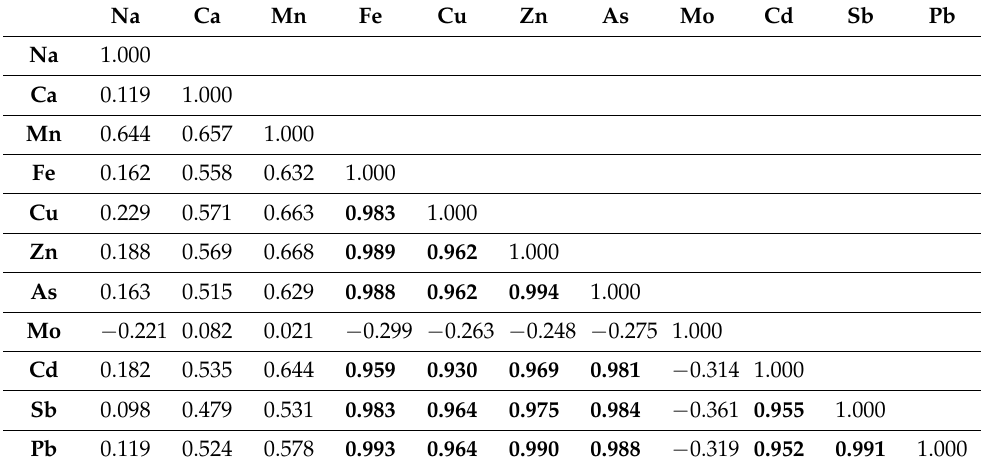
Table 5. Correlation matrix from chemical elements of PM 10 analyzed by